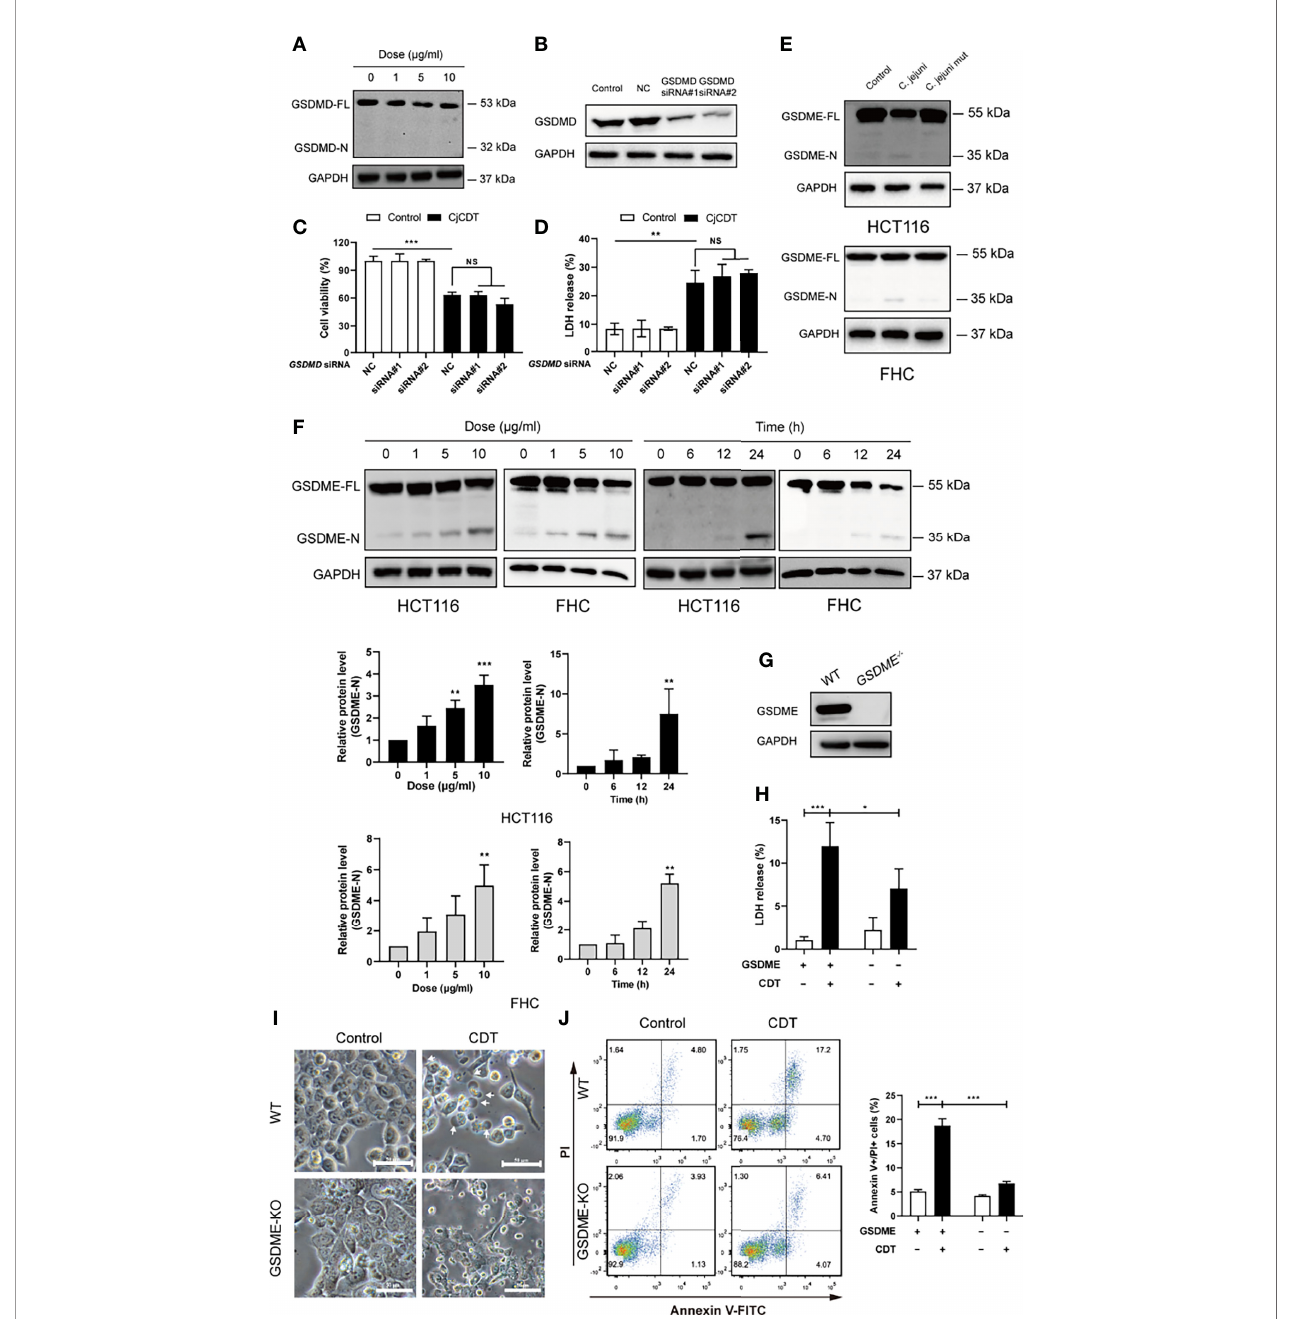
FIGURE 3 | GSDME rather than GSDMD is essential for CjCDT induced-pyroptosis (A) GSDMD full length (GSDMD-FL) and N-terminus of GSDMD (GSDMD-N) were detected in HCT116 cells by Western blotting after CDT exposure (n=3). (B) The expression of GSDMD was detected in HCT116 cells by Western blotting after transfection of siRNA (n=3). (C) Cell viability was detected using CCK-8 assay after the transfected HCT116 cells were exposed to 10 m g/ml CjCDT for 24 h (n=3). (D) LDH release was then measured after the transfected HCT116 cells were exposed to 10 m g/ml CjCDT for 24 h. (E) GSDME full length (GSDME-FL) and N- terminus of GSDME (GSDME-N) were detected by Western blotting after bacterial lysates exposure (n=3) (F) GSDME full length (GSDME-FL) and N-terminus of GSDME (GSDME-N) were detected by Western blotting after CjCDT exposure (n=3) (G) GSDME knockout cell line was identi fi ed using Western blotting. (H) LDH release assay (n=3), (I) microscopic imaging and (J) annexin V-FITC/PI assay (n=3) were used to explore the role of GSDME in pyroptosis (n=3). White arrowheads indicate the pyroptotic cells characterized with large bubbles emerging from plasma membrane Scale bar 50 m m. NS, no signi fi cant difference, * P < 0.05, ** P < 0.01, *** P < 0.001 versus control using one-way